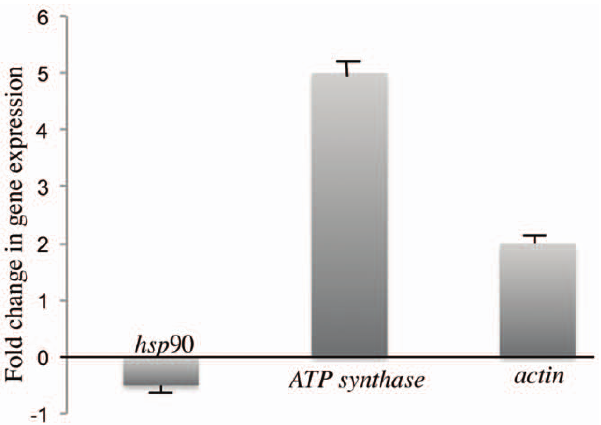
Figure 3. Regulation of actin,hsp 90 and ATPsynthase genes in Aedesaegypti larvae after 5 h intoxication with LC 50 of Cry11Aa toxin analyzed by quantitative qRT-PCR assays.